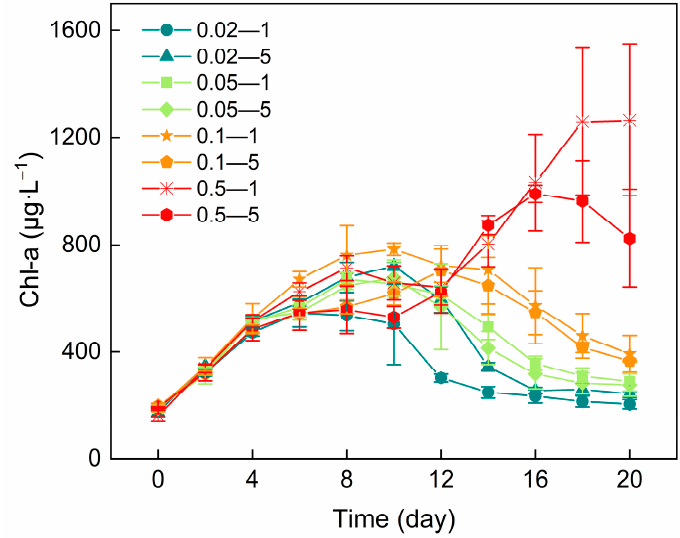
Figure 2. The changes in the Chl-a of C. ovalisporum in the different treatments.